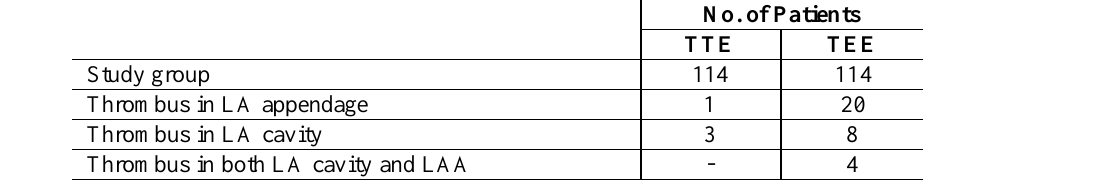
Table II : Comparative results of TTE and TEE studies